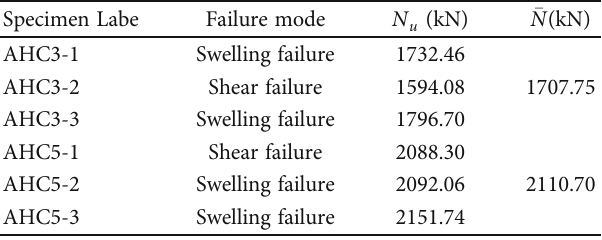
Table 5: Axial compression test data.